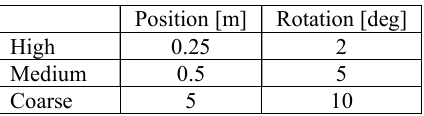
Table 1. Threshold values for RobotCar